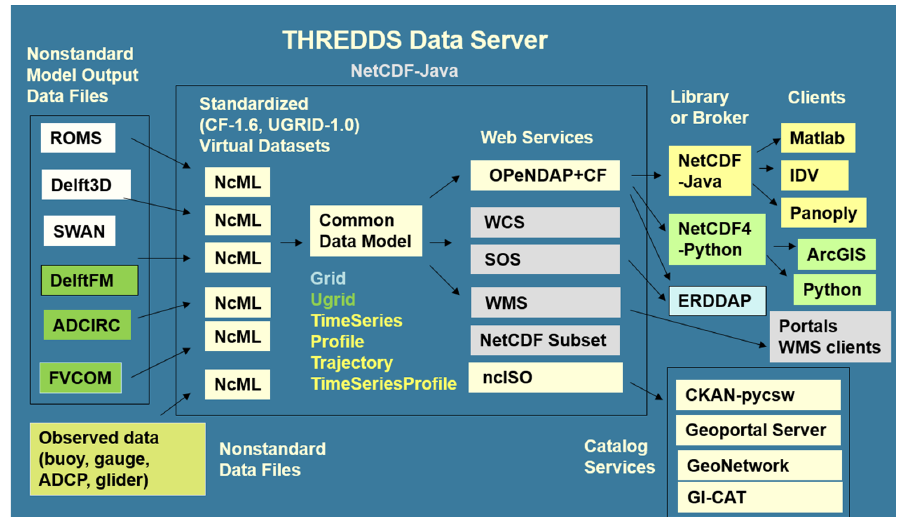
Figure 3. IOOS data interoperability approach using the Unidata THREDDS Data Server.